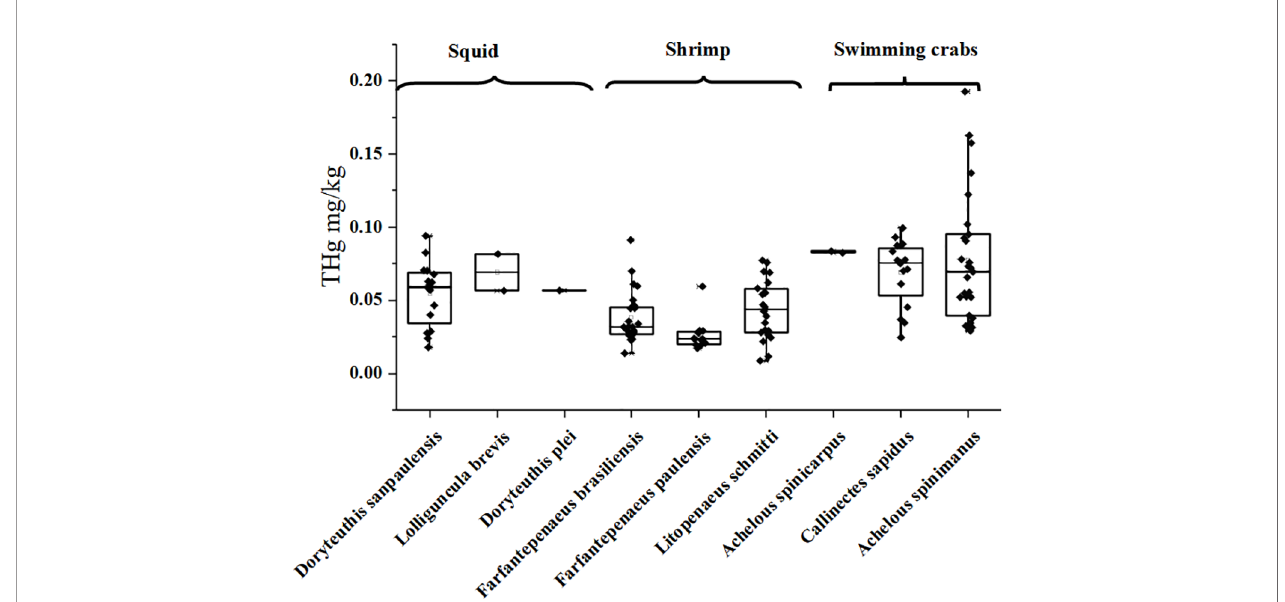
FIGURE 2 | Box-plot representing THg concentrations (mg/kg) in different species of squid, shrimp and swimming crabs collected in Guanabara